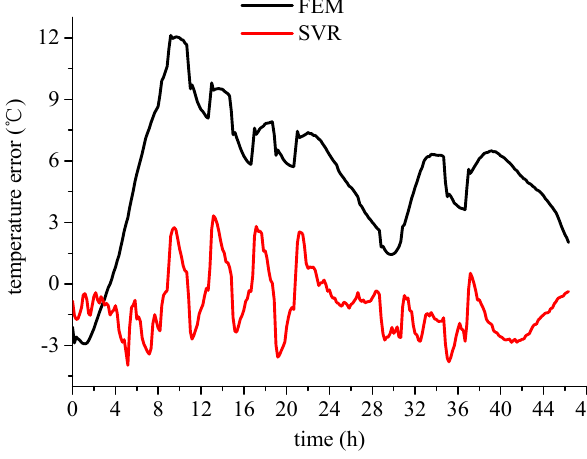
Figure 17. The temperature errors of the proposed method and FEM when λ a = 0.04 W/(m·K).